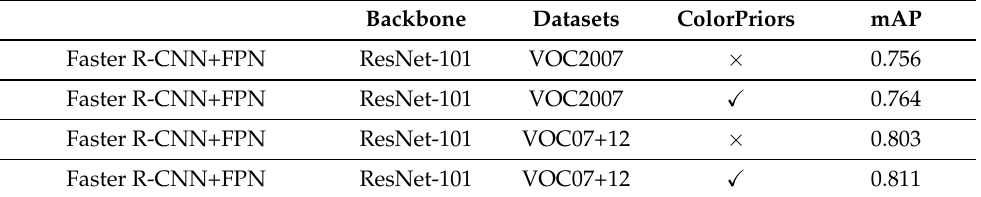
Table 1. Performance comparison of whether to use the color prior model.